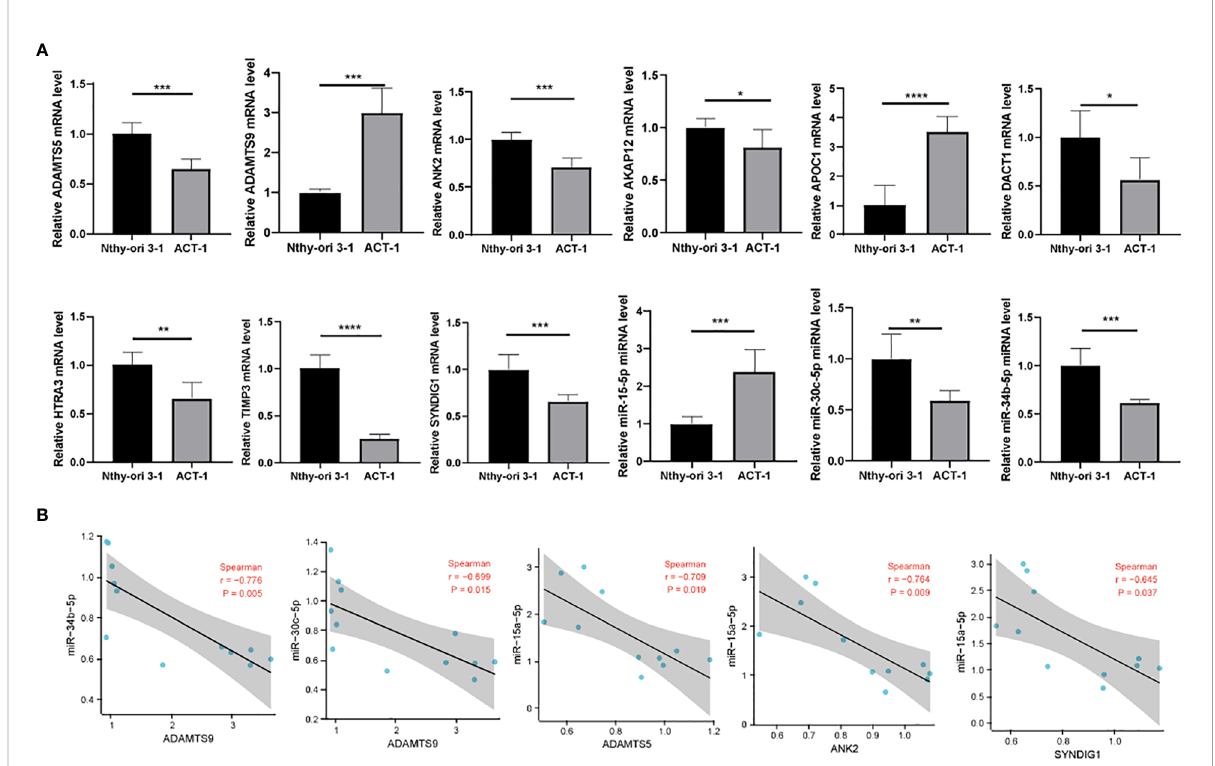
FIGURE 8 Correlation of experimental cellular miRNAs with target genes. (A) RT-qPCR detection of ADAMTS5, ADAMTS9, ANK2, AKAP12, APOC1, DACT1, HTRA3, TIMP3, SYNDIG1 , miR-15a-5p, miR-30c-5p, and miR-34b-5p expression levels; (B) Correlation analysis of miR-15a-5p, miR-30c-5p, and miR-34b-5p and their target genes. * means p <0.05; ** means p < 0.01; *** means p < 0.001; **** means p <